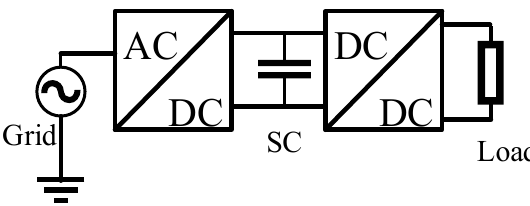
Figure 15. Schematic diagram of a parallel system of supercapacitors and loads.